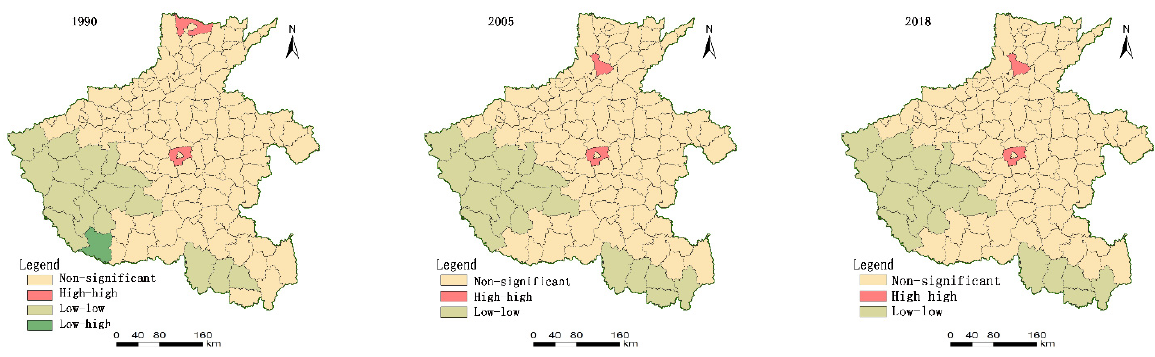
Figure 7. Local spatial autocorrelation graph of county dynamics in the territorial space of Henan from 1990 to 2018.